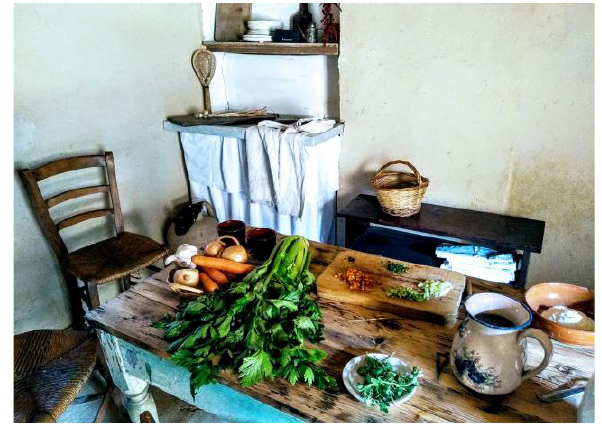
Figure 3. The kitchen of the